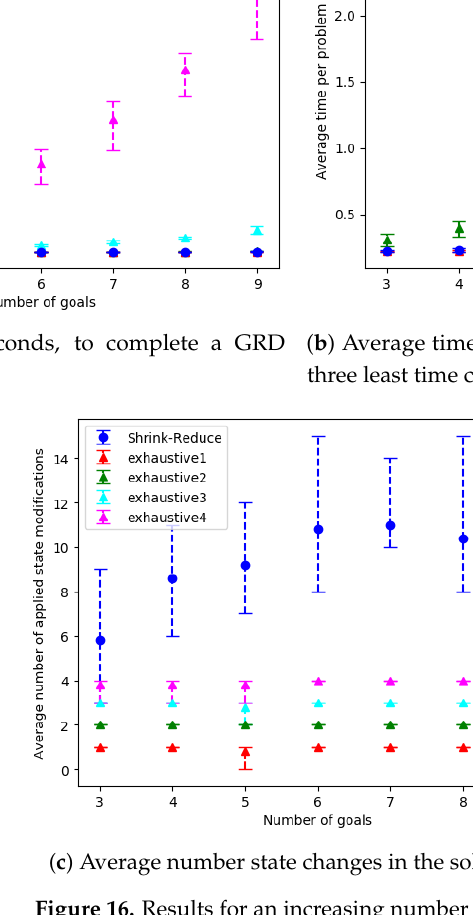
Figure 16. Results for an increasing number of goals.